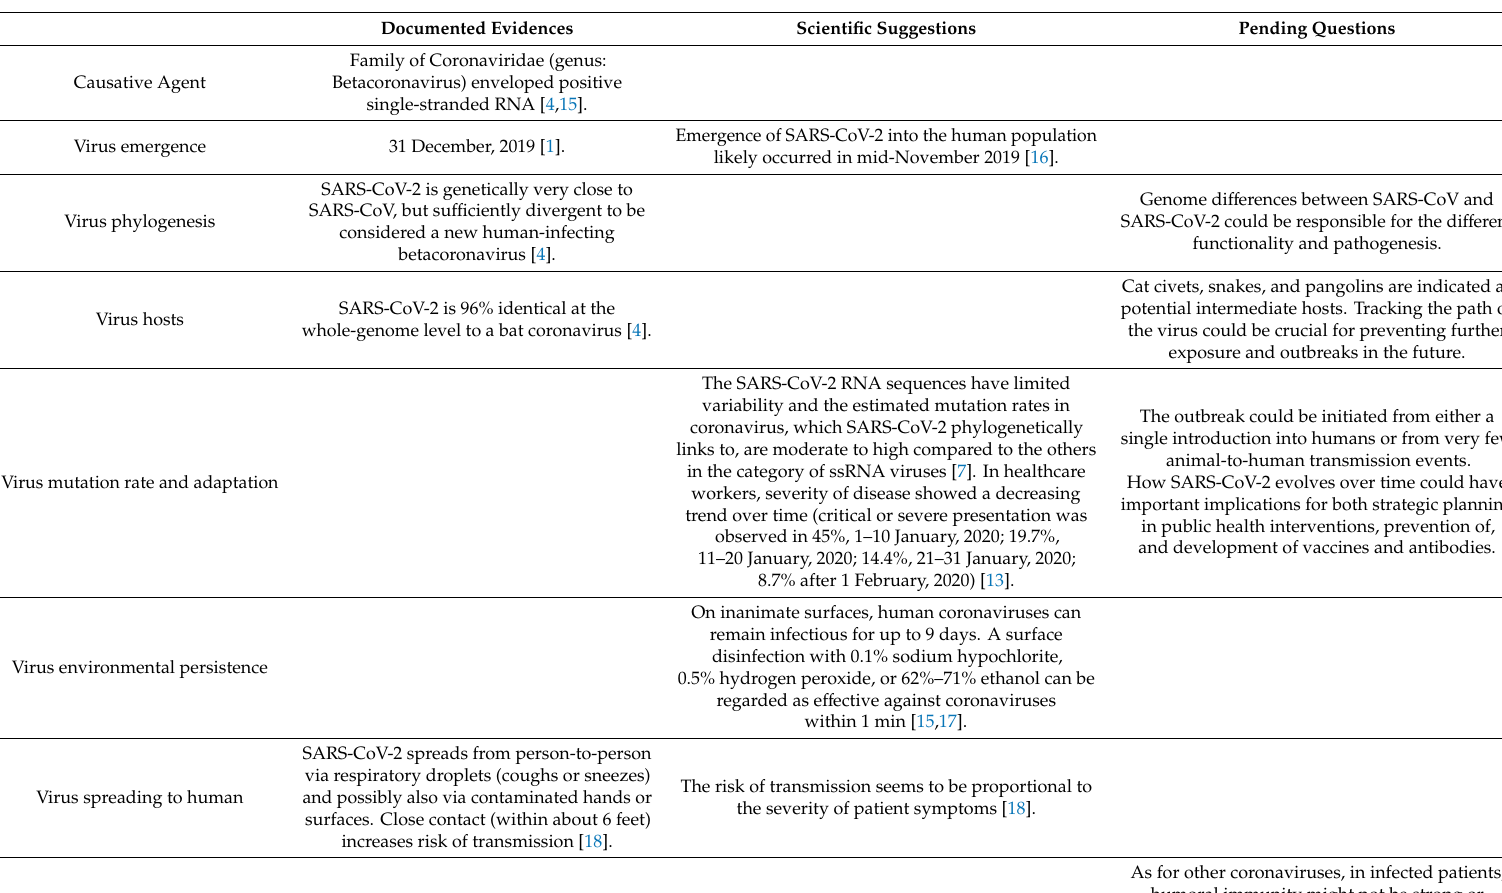
Table 1. Summary of the scientific evidences, suggestions, and pending questions on the 2019 SARS-CoV-2